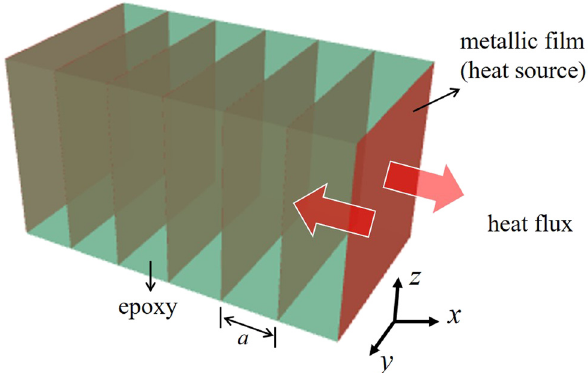
Figure 1: Schematic diagram of the laminated structure composed of viscoelastic epoxy and periodically distributed metallic fi lms.